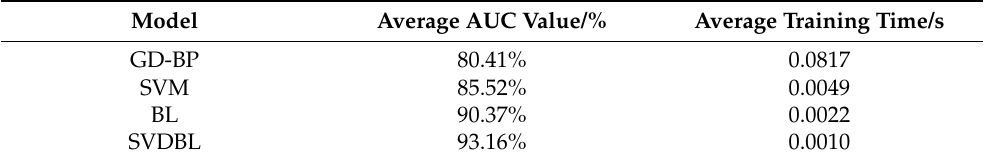
Figure 14. Average ROC curves of four models. Table 8. Comparison of average ROC curves.